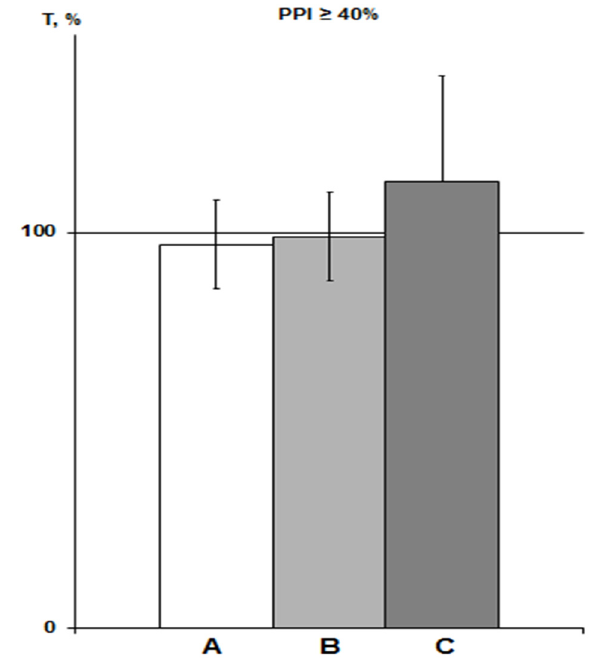
Figure 3. PPI-associated average T values in various saline groups of rats with PPI ≥ 40% exposed to SHBH 4 min after HBH. The T values (means ± SEM%) are expressed as a percentage of ideal T values as a function of the corresponding PPI (see Section 4.9). A, saline IP group of previous experiments (n = 17); B, saline IP group of this experiment (n = 7); C, saline iHippo group of this experiment (n = 3).